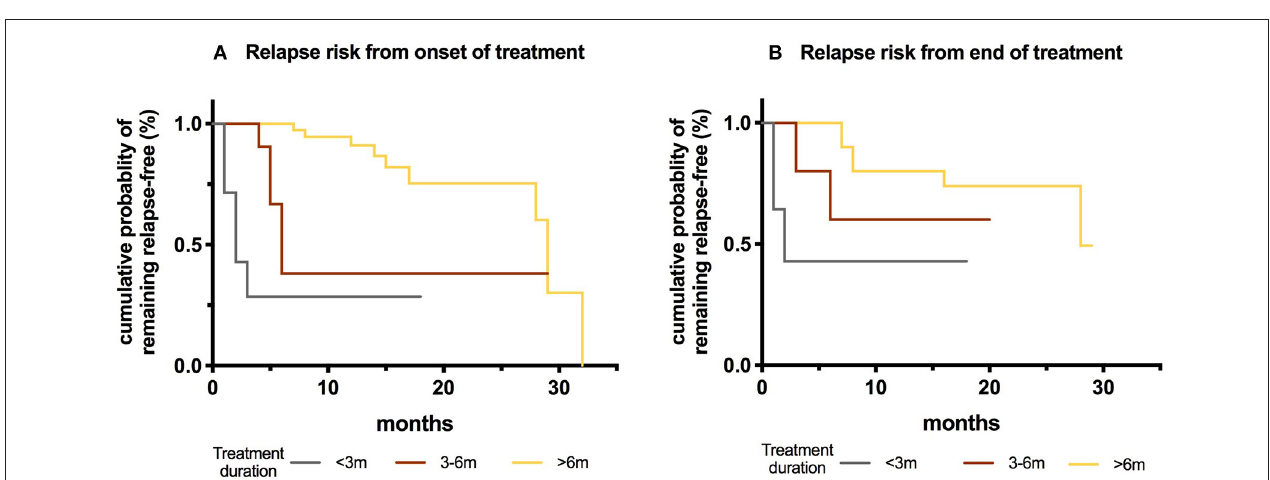
FIGURE 4 | Kaplan-Meier curves showing risk of relapse depending on the duration of oral prednisone taper in MOG-ab-positive patients. (A) Treatment duration from onset of disease: < 3 months, between 3 and 6 months and > 6 months. (B) Observation time after the treatment cessation.